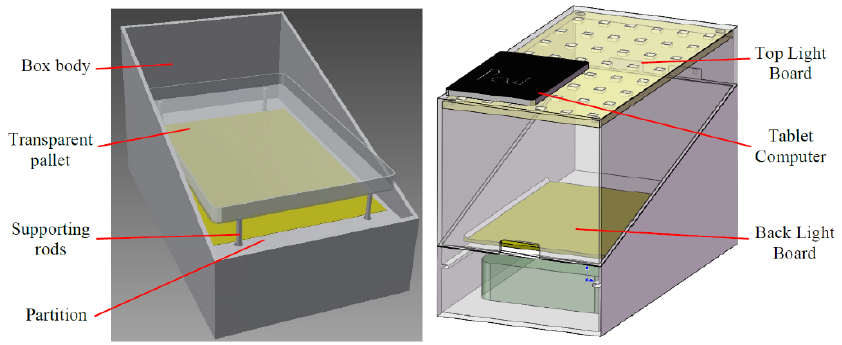
Figure 2. Internal structure of the phenotype instrument.